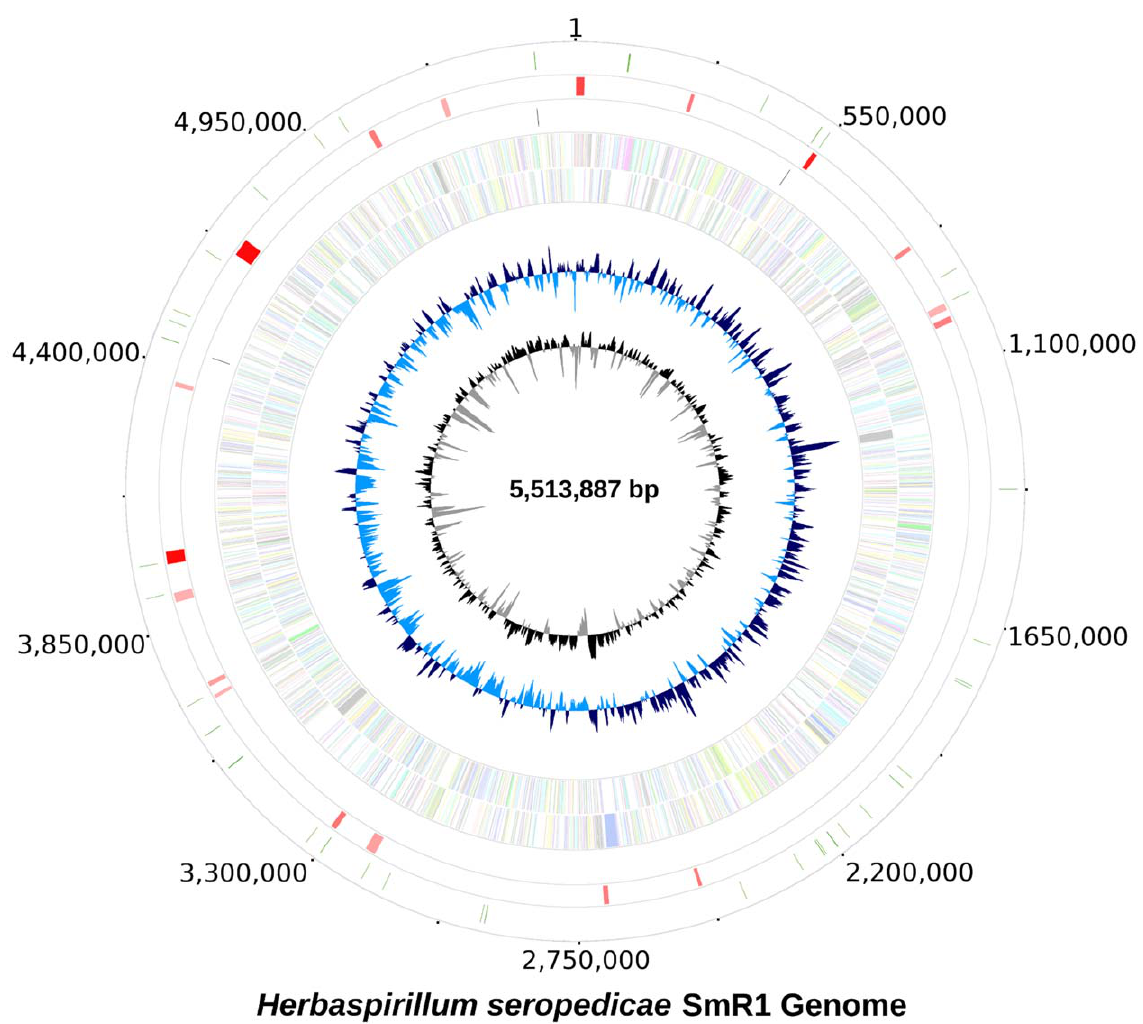
Figure 1. The genome of Herbaspirillumseropedicae SmR1. From inside to outside 1) G + C content; 2) GC skew; 3) genes color-coded according the COG functional categories; genes in the + strand and 2 strand are represented in the inside and outside circles respectively; 4) rRNAS operons; 5) putative horizontally transferred regions identified using IVOM: light red indicates low score and dark red indicates high score; 6) regions of H. seropedicae genome identical to castor bean ( Ricinus communis ) sequences (minimum of 200 bp in length and higher than 90% in